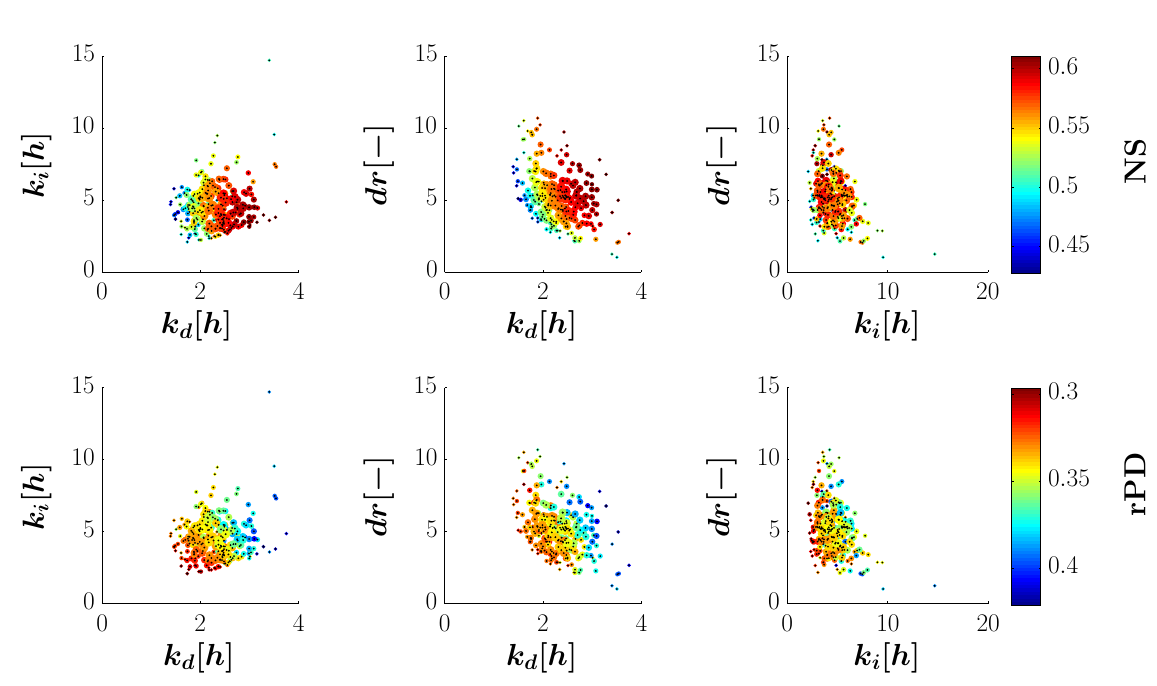
Fig. 11: Scatter plot of the good parameter vectors shaded according to their validation performance for the criteria NS and rPD. Red points have a good validation performance, blue points are worse (cf. colorbar). The size of the shades is proportional to the data depth of each point with respect to the whole cloud.